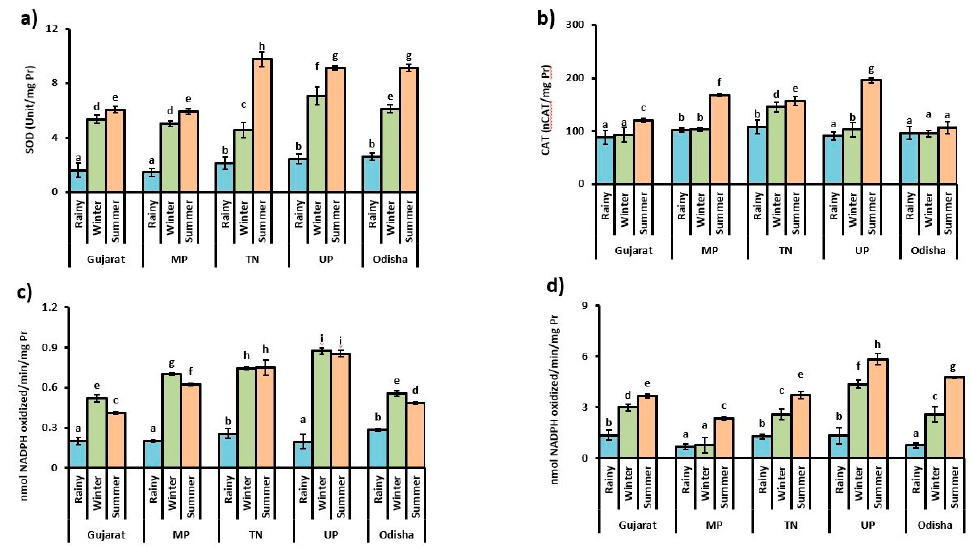
Figure 2. Seasonal variation of antioxidant enzyme activities of P. globosa . ( a ) superoxide dismutase, ( b ) catalase, ( c ) glutathione peroxidase, ( d ) glutathione reductase. The data represent mean ± SEM with superscripts indicating statistical differences between mean values at p < 0.05 level.